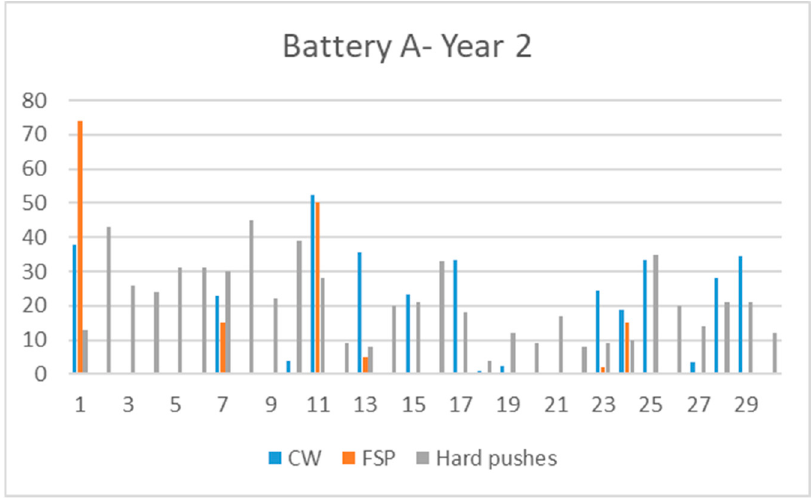
Figure 9. Hard pushes and refractory repairs battery A, year 2.